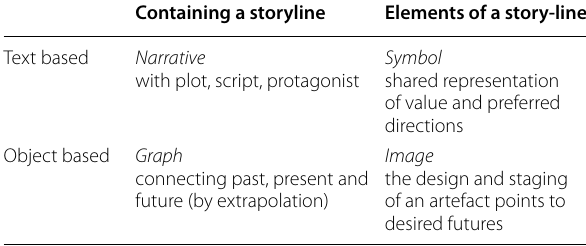
Table 3 Ingredients of futures